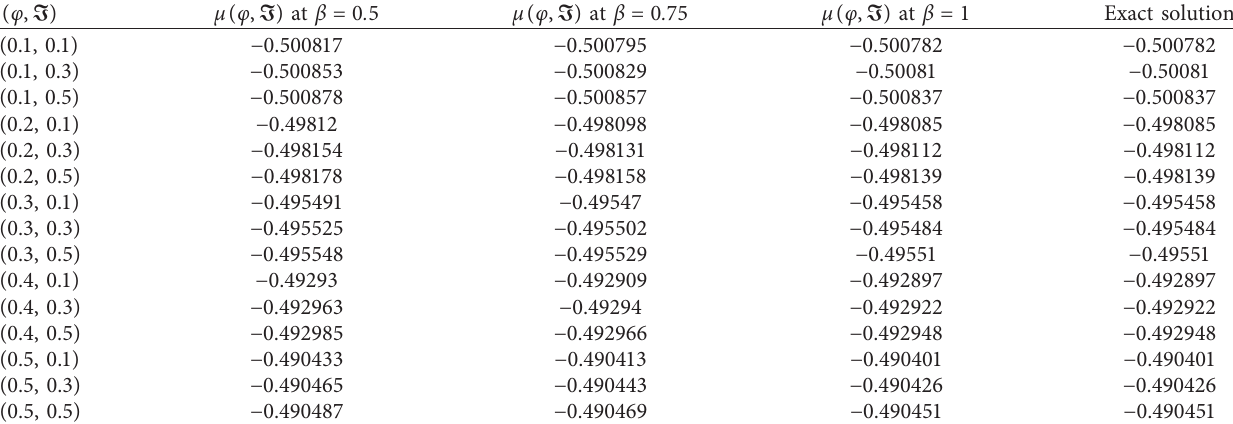
Table 1: HPTM for the approximate solution of Example 1.